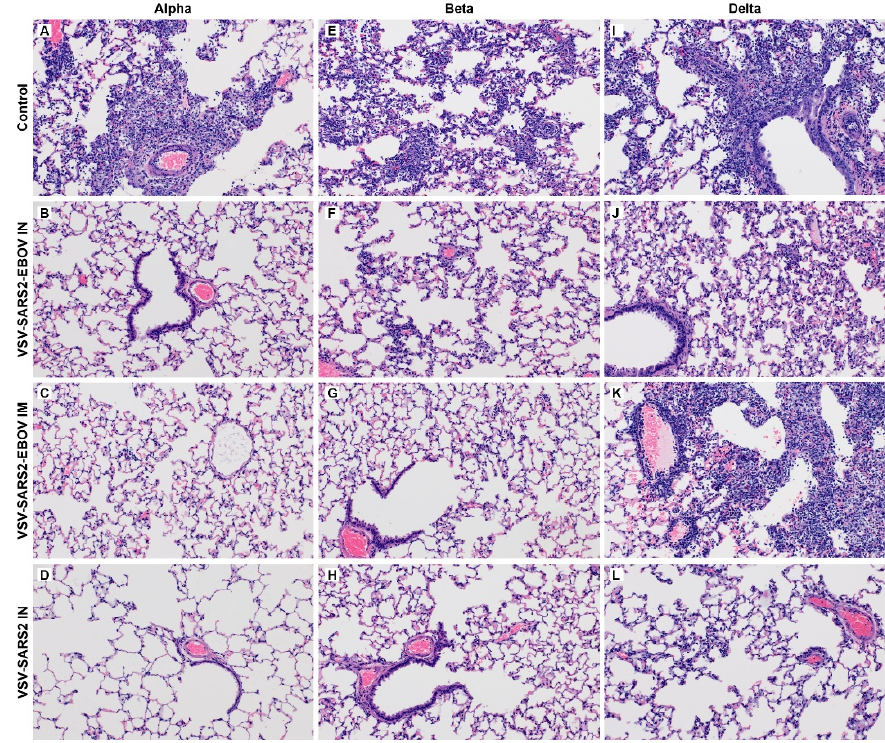
Figure 1. Histopathology of hamster lungs. Hamsters were vaccinated intramuscularly (IM) or intranasally (IN) 28 days prior to IN challenge with SARS-CoV-2 Alpha ( A – D ), Beta ( E – H ), and Delta ( I – L ) variants of concern (VOC). At 4 days post challenge (DPC), lung samples were collected and stained with H&E (200×). Moderate broncho-interstitial pneumonia and alveolar exudate was observed in all unvaccinated (control) hamsters regardless of the challenge variant ( A , E , I ). No ( B , D ) or minimal ( C ) interstitial pneumonia was observed in vaccinated, Alpha VOC-challenged hamsters. Minimal interstitial pneumonia was observed in vaccinated, Beta VOC-challenged hamsters ( F – H ). Minimal to mild interstitial pneumonia was observed in IN-vaccinated, Delta VOC-challenged hamsters ( J , L ). Histopathologic lesions were observed in IM-vaccinated, Delta VOC-challenged hamsters ( K ).